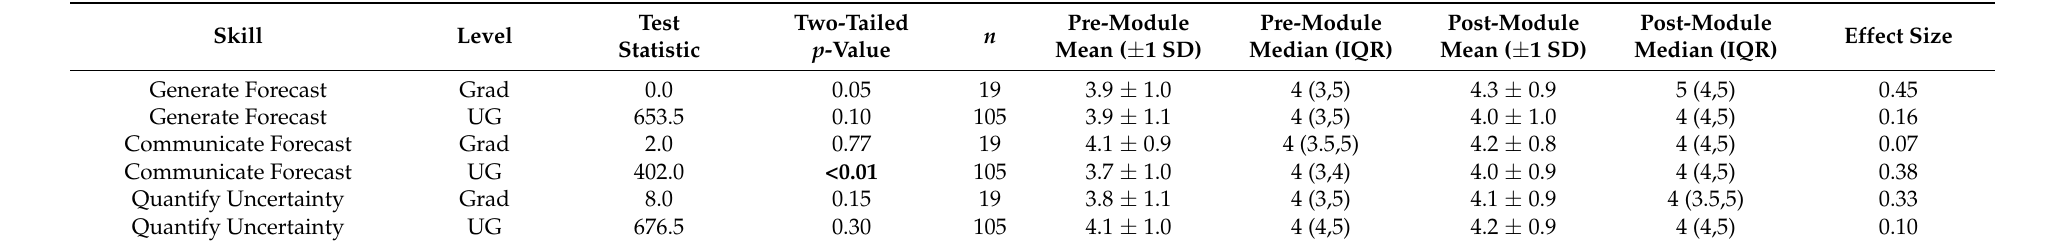
Table A11. Differences in students’ self-reported assessment of the importance of generating a forecast, communicating a forecast, and quantifying uncertainty between pre- and post-module assessments for graduate (Grad) and undergraduate (UG) level of students. Test statistics and p -values are for paired, two-sided Wilcoxon signed-rank tests; pre- and post-module means are reported with the standard deviations (SD) along with pre- and post-module medians and the interquartile range (IQR). Significant p -values ( p < 0.05) are shown in bold. Questions used a Likert-type scale from 1 (low) to 5 (high)